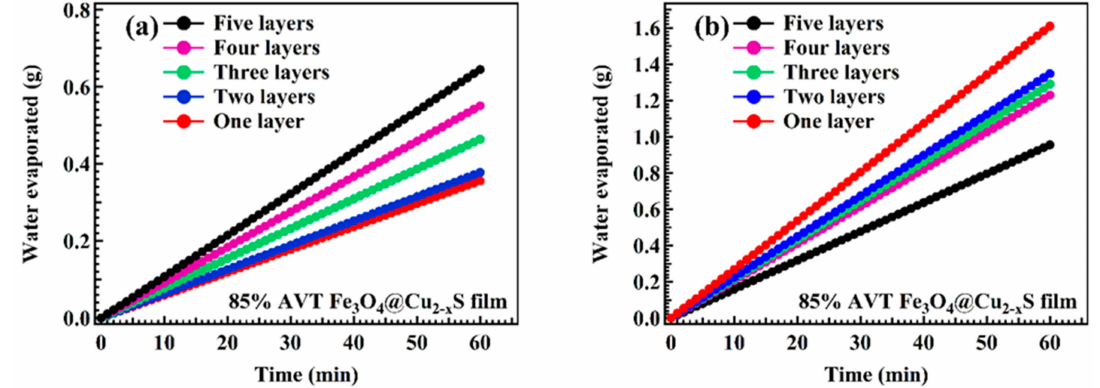
Figure 16. Water evaporation rate vs. time for Fe 3 O 4 @Cu 2 − x S-coated Petri dishes ( a ) without simulated solar light on and ( b ) with simulated solar light on. However, turning on the simulated solar light for 60 min, the Fe 3 O 4 @Cu 2 − x S film was photonically activated to generate heat responsible for increased evaporation